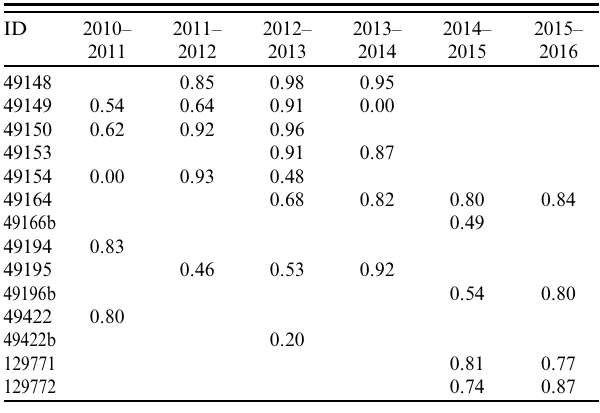
Table 3 . Overlap of foraging home ranges between successive breeding seasons for 15 adult Reddish Egrets ( Egretta rufescens ) breeding in the Laguna Madre in 2010–2016 using Bhattacharyya’s Affinity